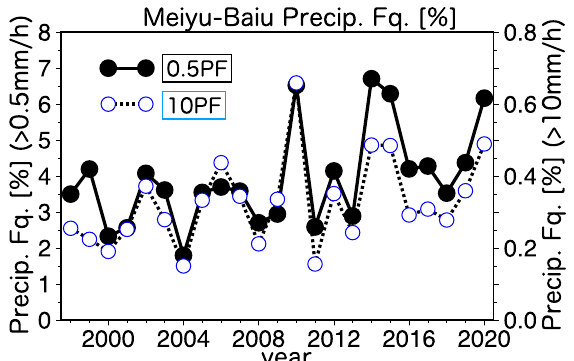
Figure 3. Time series of interannual variations in the frequency of Meiyu–Baiu band precipitation (27–33º N, 115–135º E). Precipitation (0.5 mm/h; black solid line with closed circles) and heavy precipitation (10.0 mm/h; dashed line with opened circles) frequencies from 1998–2020 are shown. The definition of rainfall frequency is the same as in Fig. 2. The rainfall frequency was averaged along the Meiyu–Baiu band in the Meiyu–Baiu season each year.